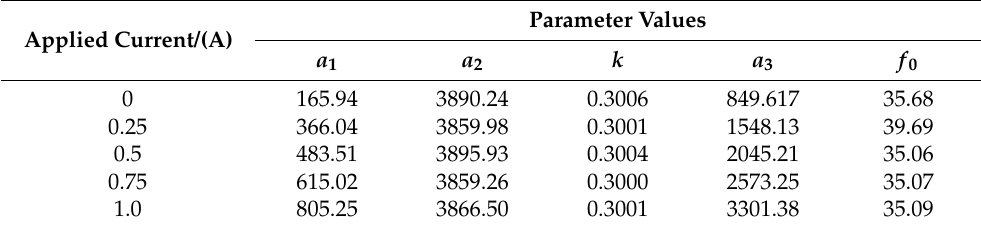
Table 1. Parameter identification results of MR damper model. Applied Current/(A)